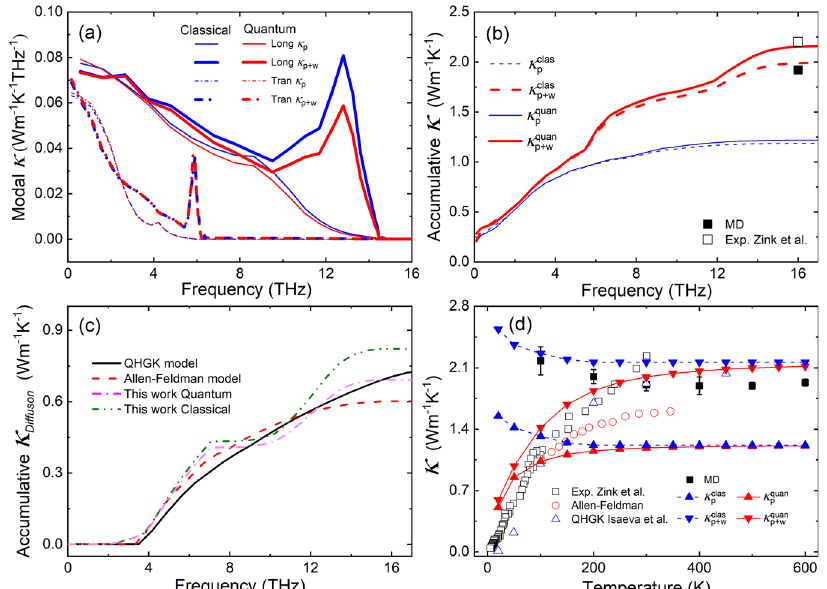
Fig. 5 The thermal conductivity of amorphous silicon. a Modal classical and quantum thermal conductivities ( κ ) of amorphous silicon for the longitudinal (Long) and transverse (Tran) polarizations, respectively, from the particlelike ( κ p ) and overall (particlelike + wavelike ( κ p + w )) contributions at 300 K. b Accumulative thermal conductivities versus frequency at 300 K. c Accumulative thermal conductivities of diffusons versus frequency from the quasi-harmonic Green-Kubo (QHGK) model, the Allen-Feldman model and this work at 300 K. d Thermal conductivities versus temperature. The symbols refer to experimental results (Exp.) 44 , QHGK model, Allen-Feldman model and our molecular dynamic (MD) simulations, see calculation details in Supplementary